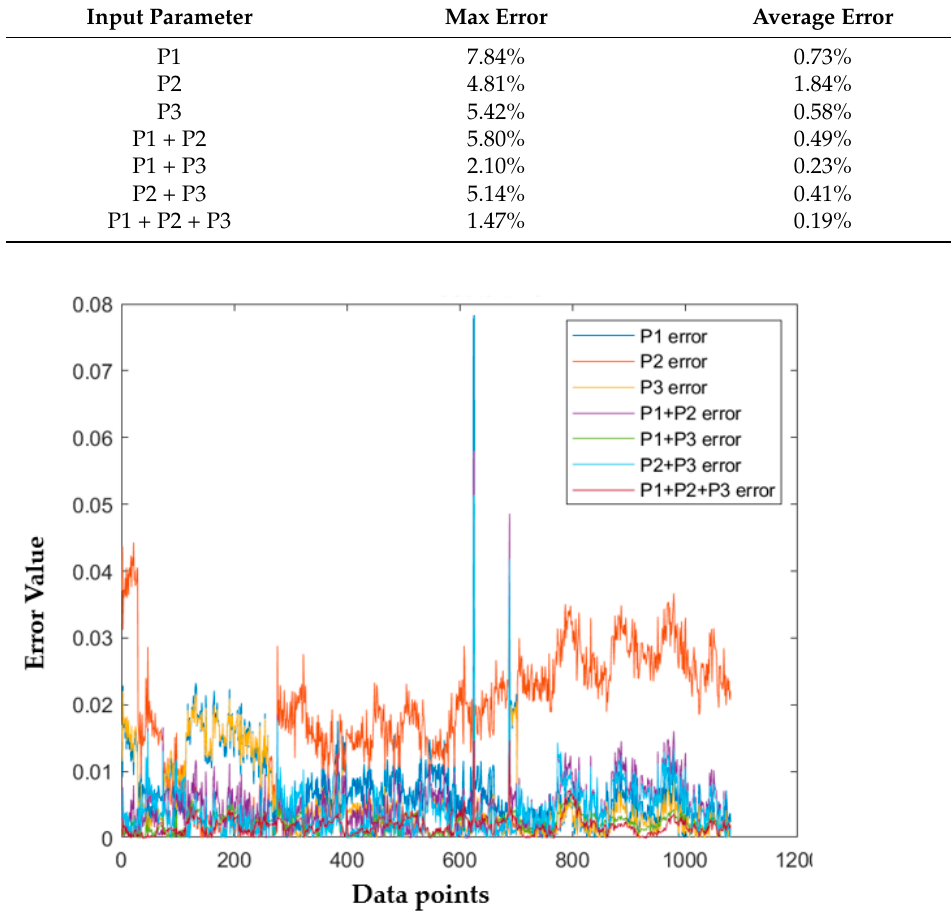
Figure 15. ANN result error. Table 3. Test data for P1, P2, P3 and P1 + P2.